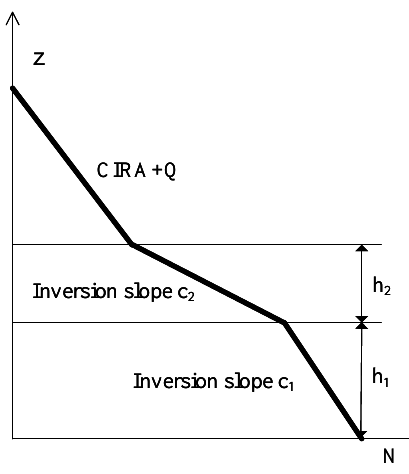
Figure 3. Geometric scheme of refractivity profile model.